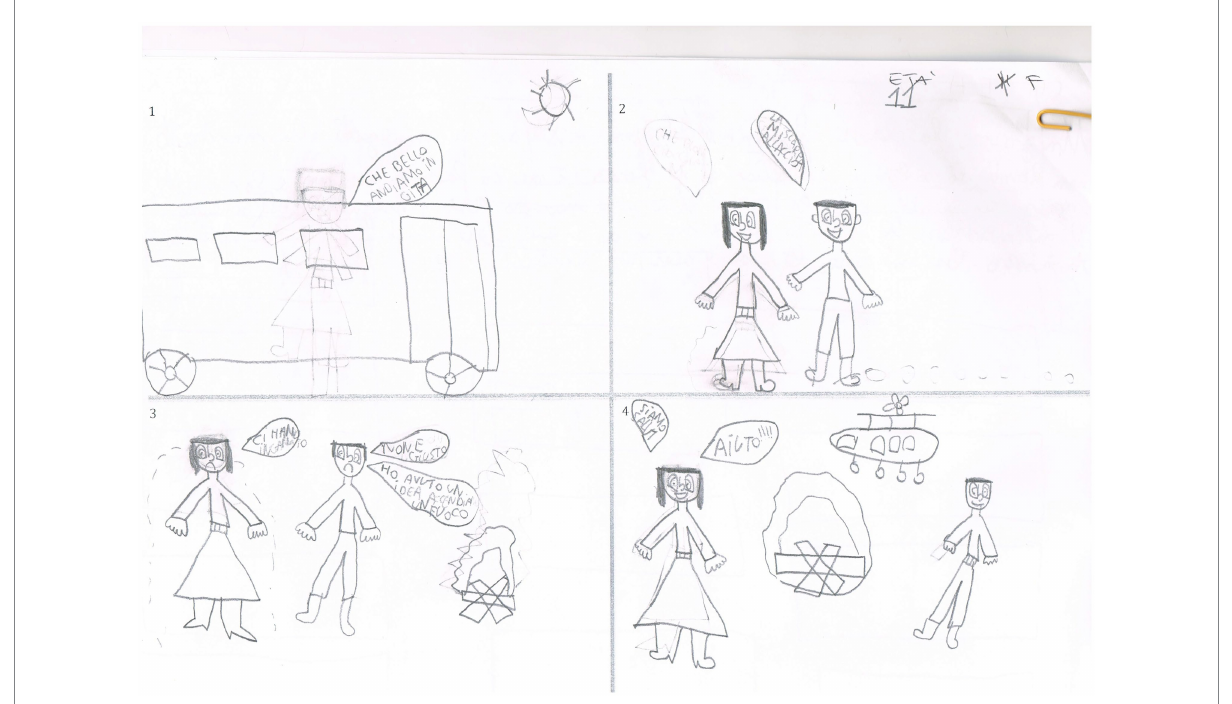
FIGURE 2 Drawn Stories Technique. Positive compensated outcome (PCO) example: “ During a school trip, two scholars stop to look at the landscape but are abandoned by the rest of the class. Finally, they light a fire and have been saved with an helicopter.” Male, 11 years old.